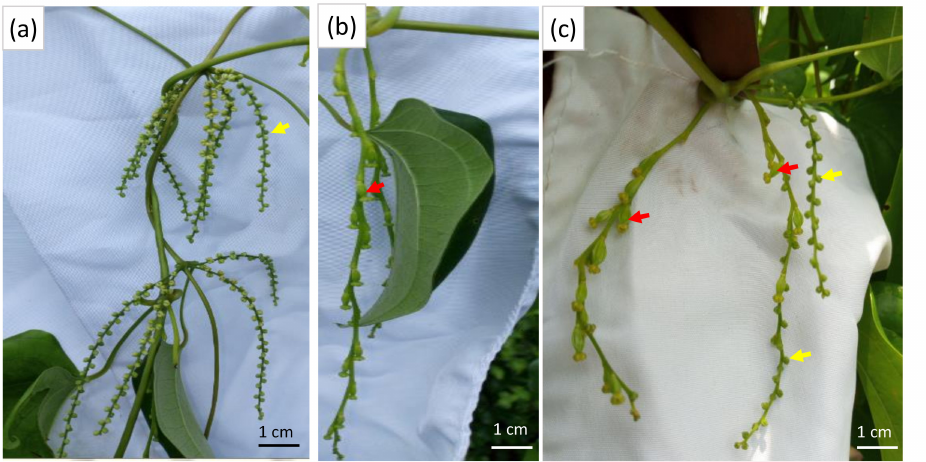
Figure 1. Inflorescences of ( a ) male, ( b ) female and ( c ) monoecious individuals of D. rotundata grown under field condition at the Centre de Recherche, de Formation, d’Incubation et d’Innovation pour le D é veloppement Agricole (CREFIISDA) (Zogbodomey, Benin) four months after sowing (three months after tuber germination). Yellow arrows and red arrows indicate, respectively, male and female